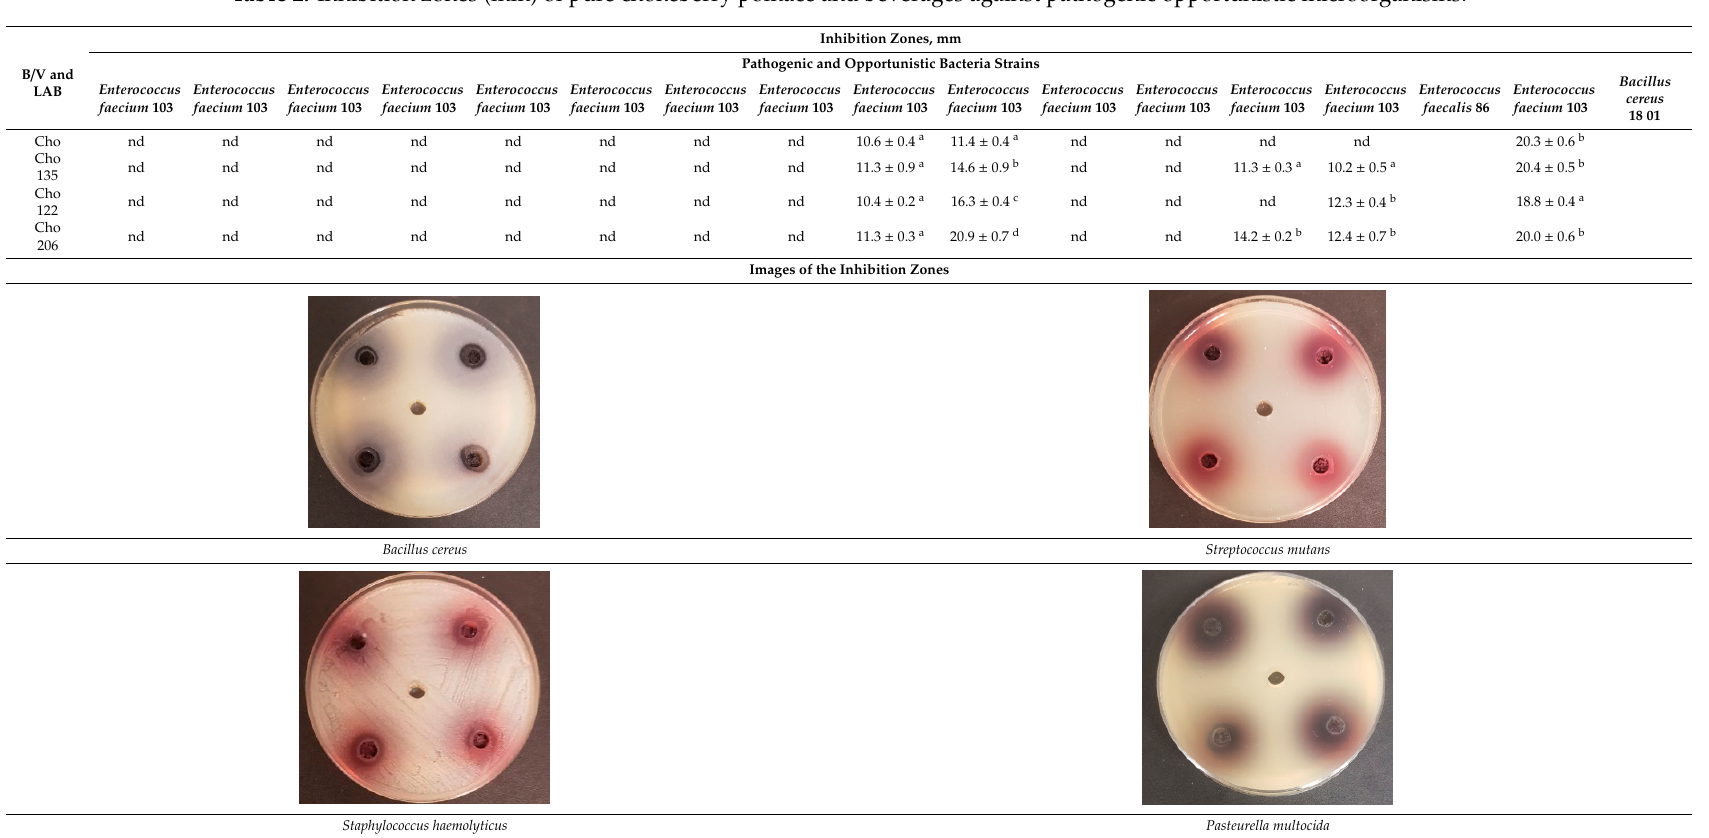
Table 2. Inhibition zones (mm) of pure chokeberry pomace and beverages against pathogenic opportunistic microorganisms.